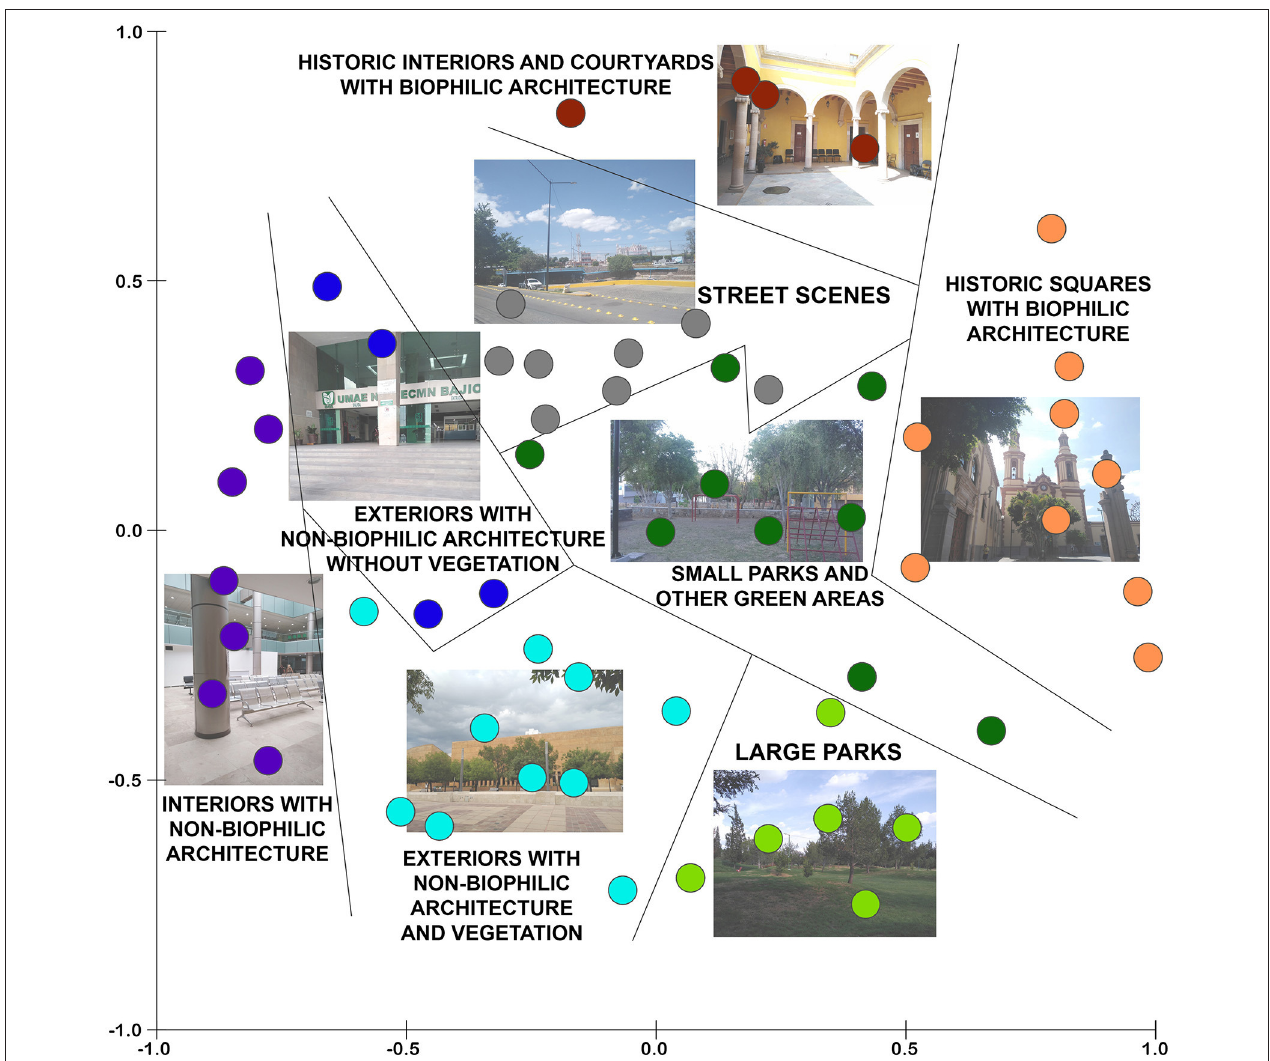
FIGURE 4 | Multidimensional scaling (MDS) displaying the studied places in Leon, Mexico, grouped into eight categories (one photograph is presented for each category of place). The MDS is based on the similarities of the places regarding the 12 environmental dimensions.